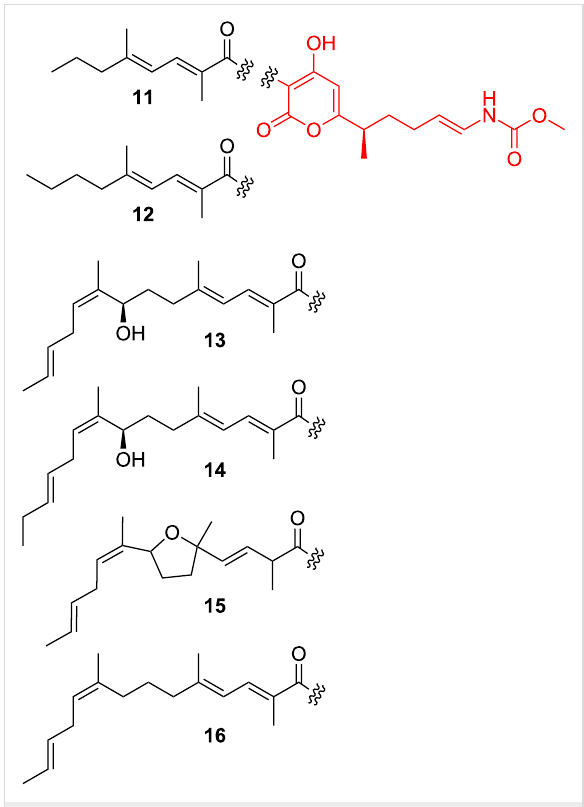
Figure 3: Structures of myxopyronins A ( 11 ) and B ( 12 ), corallo- pyronins A ( 13 ), B ( 14 ) and C ( 15 ), as well as precorallopyronin A ( 16 ).